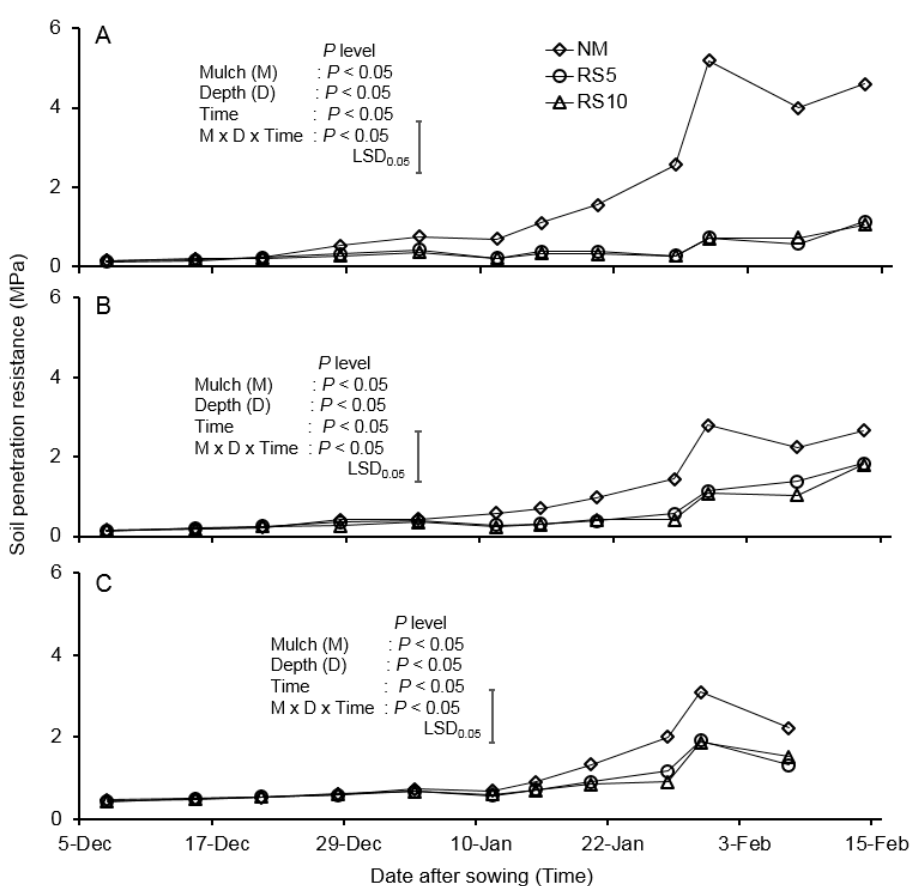
Figure 4. Effects of mulch on soil penetration resistance in the 2018–2019 season: ( A ) at 0–7 cm, ( B ) 7–15 cm, and ( C ) 15–30 cm. LSD 0.05 is the least significant difference of the interaction between mulch, depth and time in each graph at a p -value of 0.05. NM = no-mulch; RS5 = rice straw at ~5 t ha − 1 ; RS10 = rice straw at ~10 t ha − 1 . Note: 7 December was the sowing date for sunflower.